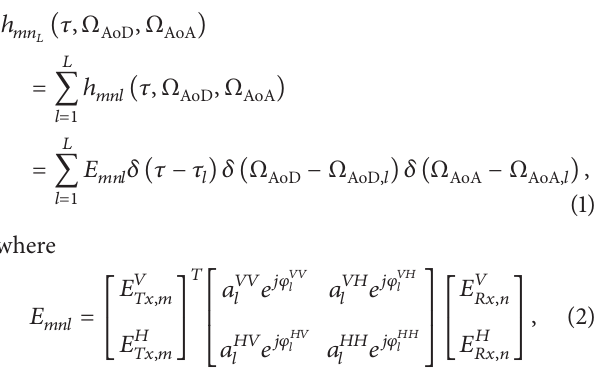
Figure 8: Picocell and macrocell MCS selection of horizontal and vertical eNB configurations at 15dB receive SNR (NLoS links only). field pattern response for the corresponding AoD/AoA and polarisation. The double-directional time-invariant channel impulse response ℎ 𝑚𝑛 for the 𝑚 th transmitting and 𝑛 th receiving antenna links is given by